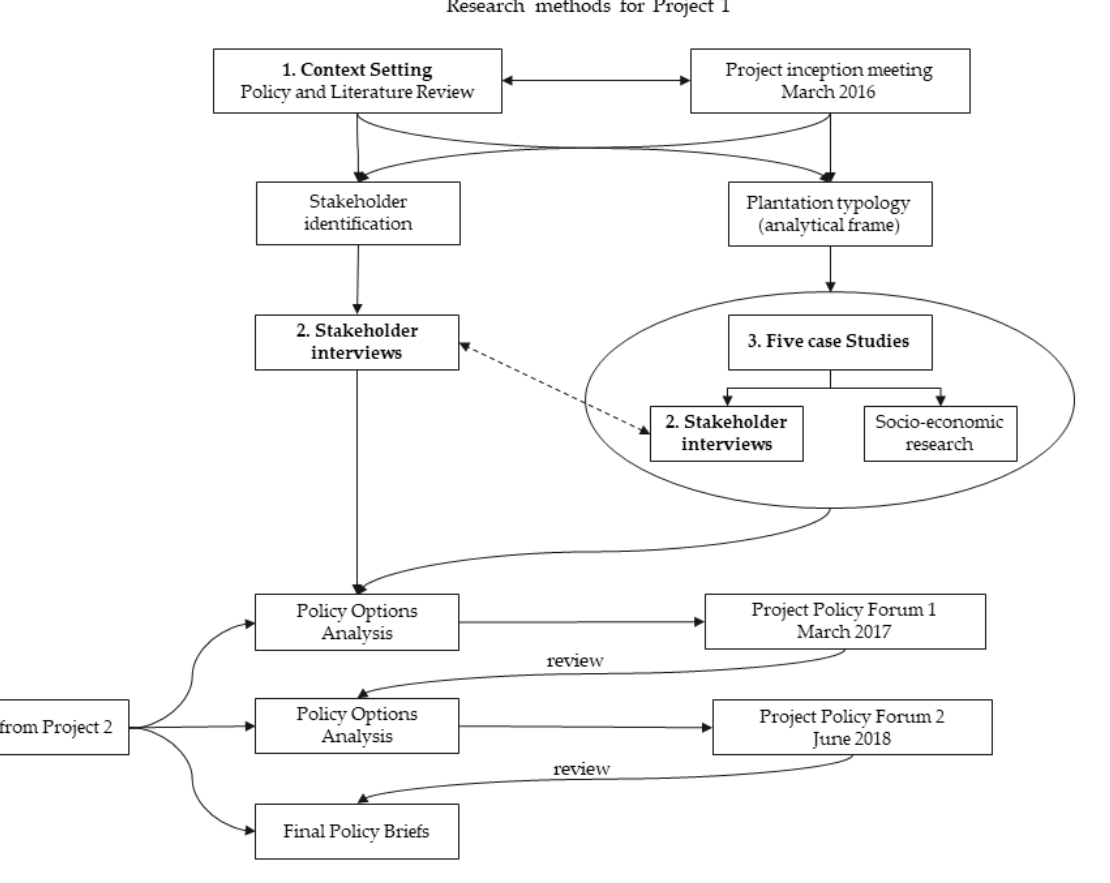
Figure 1. Research Design and Methods.